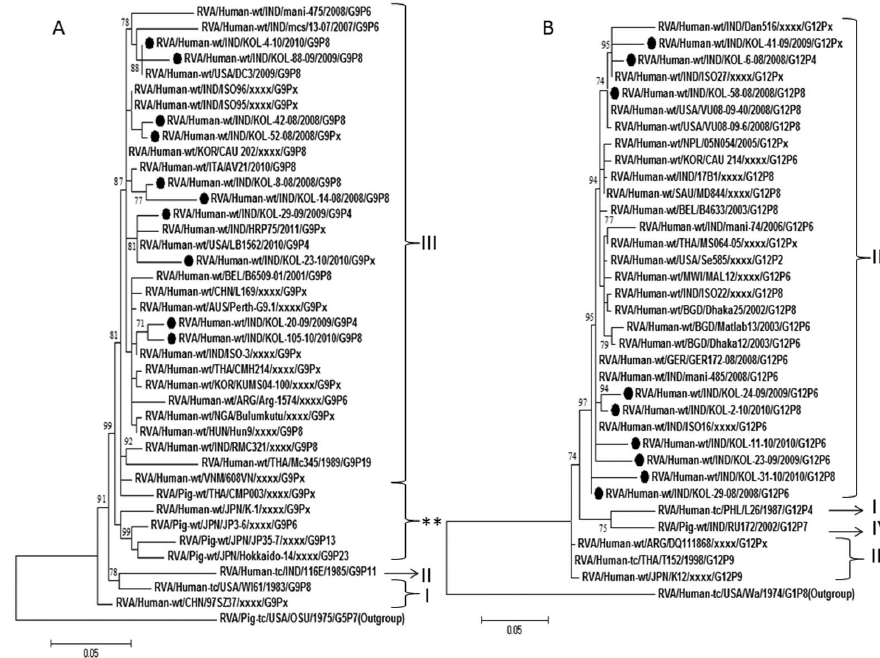
Figure 4. A and B. Phylogenetic trees of the G9 and G12 strains of Kolkata. Phylogenetic trees constructed from the nucleotide sequences of VP7 genes of A. G9; B. G12 strains of Kolkata, isolated during January 2008 through December 2010, with other representative G9 and G12 strains respectively. A. All Kolkata G9 strains showed relatedness to lineage III G9 strains. (**Sub cluster of Japanese and Chinese rotavirus strains). B. All Kolkata G12 strains clustered with lineage III G12 strains. Scale bar, 0.05 substitutions per nucleotide. Bootstrap values less than 70% are not shown.